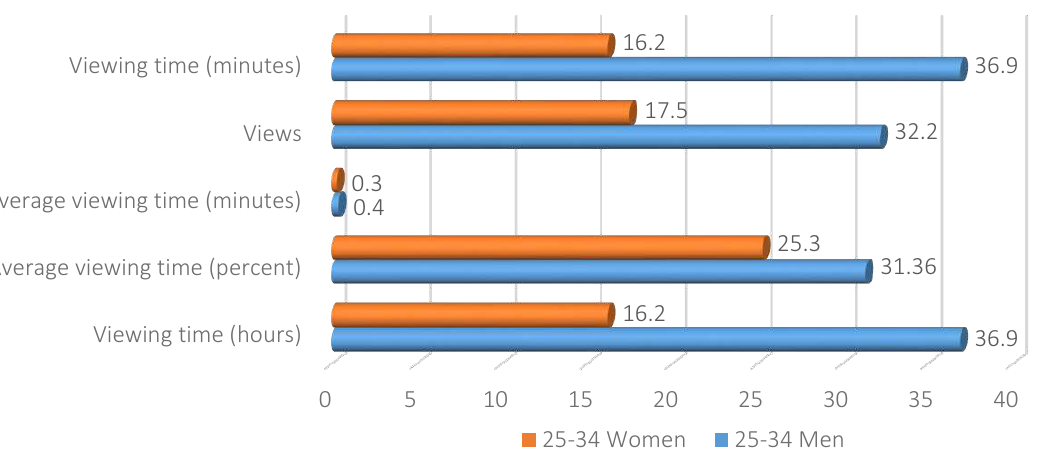
Figure 6. Gender preferences of viewing video clip during 21 days for observation by persons aged 25-34